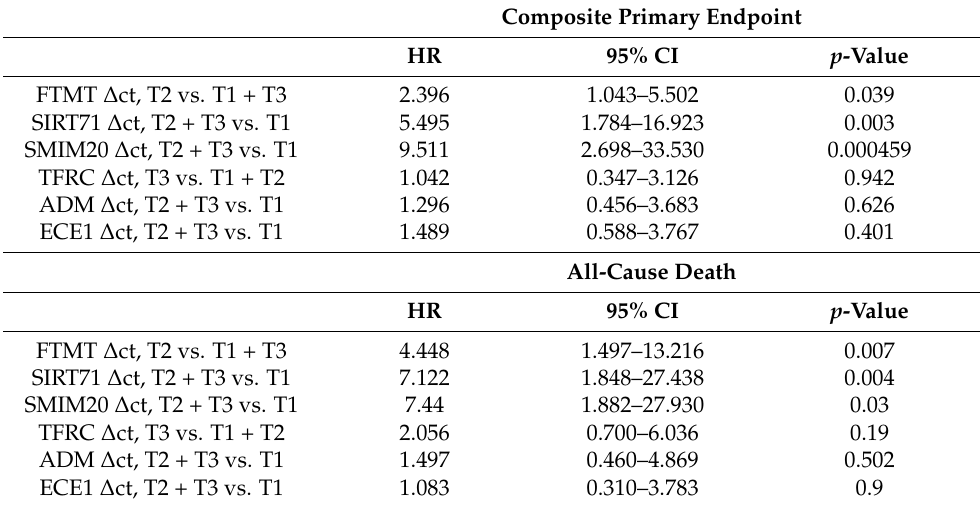
Table 4. Adjusted Cox proportional hazards analyses exploring associations of gene expression with